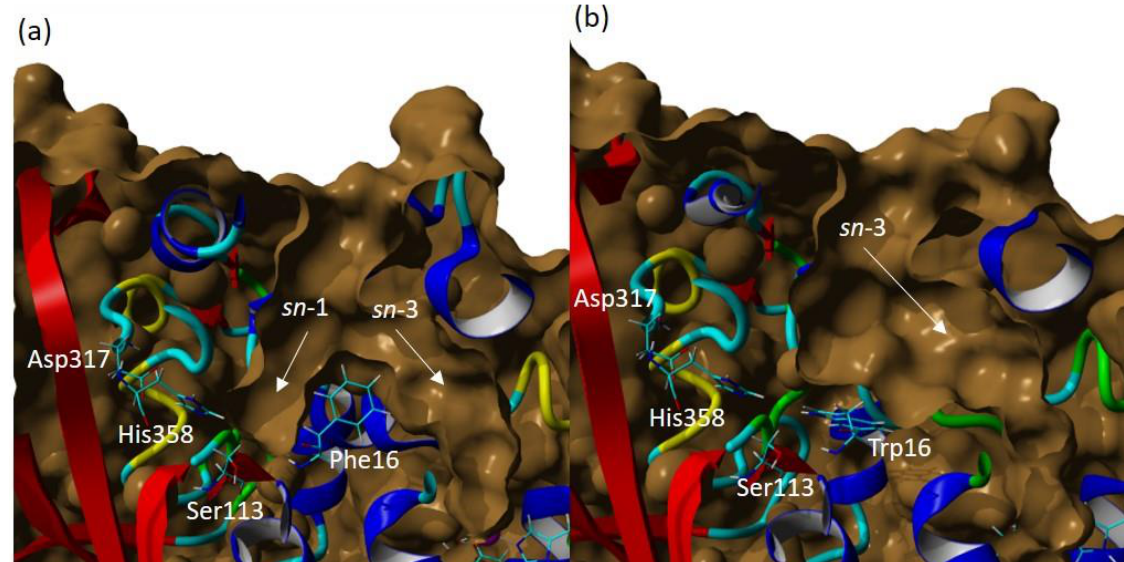
Figure 6. The surface of wt-T1 and 3M variant lipase binding sites. ( a ) wt-T1 lipase. ( b ) 3M mutant lipase . The catalytic residues are shown in a cyan colour and labelled in a white colour and the light grey surface represents the open conformation of the binding site, binding pocket sn -1 and sn -3 highlighted by the yellow